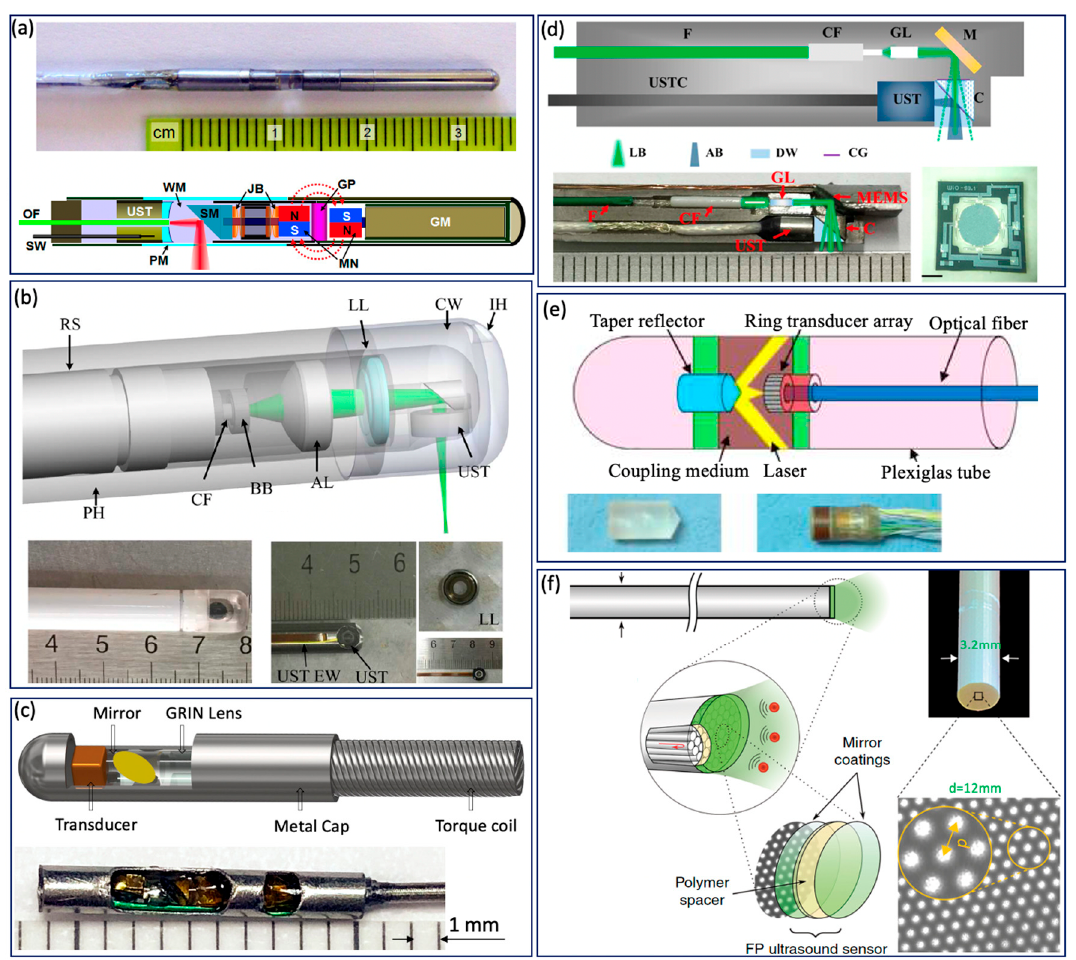
Figure 3. GI Tract PA endoscope. ( a ) Distal scanning based coaxial imaging probe. GM, geared micromotor; GP, glass partition; JB, jewel bearings; MN, magnets; OF, optical fiber; PM, plastic membrane (imaging window); SM, scanning mirror; SW, signal wire; UST, ultrasonic transducer; WM, water medium. Adapted from [42]. ( b ) Proximal scanning based coaxial imaging probe. RS, rotating shaft; LL, liquid lens; CW, coupling window; IH, inject hole; PH, plastic housing; BB, ball bearing; CF, ceramic ferrule; AL, aspheric lens; UST, ultrasonic transducer; UST EW, ultrasonic transducer electric wire. Adapted from [45]. ( c ) Proximal scanning based noncoaxial imaging probe. Adapted from [27]. ( d ) MEMS based imaging probe. F, fiber; CF, ceramic ferrule; GL, GRIN lens; M, MEMS mirror; UST, ultrasound transducer; USTC, ultra- sound transducer cable; C, cube; LB, light beam; AB, acoustic beam; DW, deionized water; CG, cover glass. Scale bar: 0.5 mm [51]. ( e ) Ring-shaped transducer array based imaging probe. Adapted from [50]. ( f ) All optical PA imaging probe. Adapted from [13].